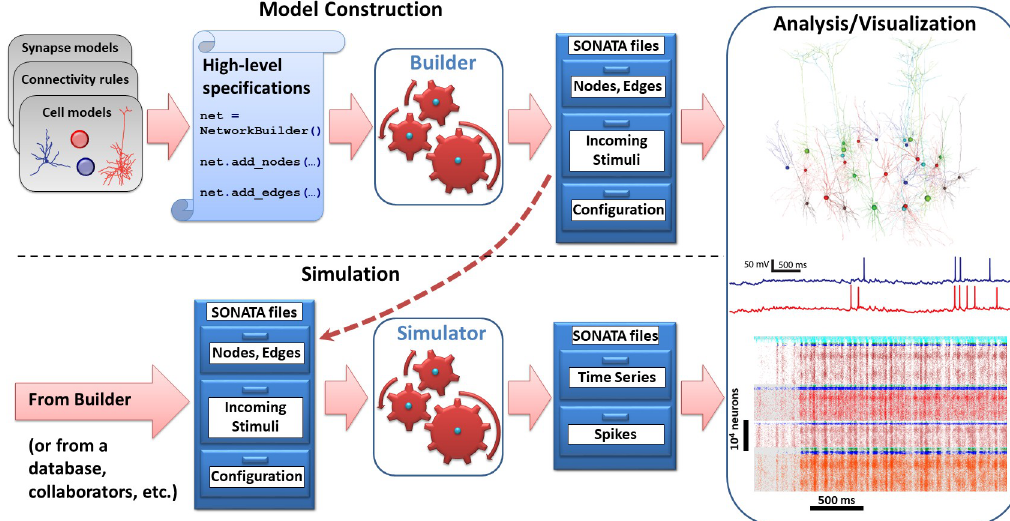
Fig 2. Basic workflow that is conserved across modules of BMTK. Input SONATA files (represented symbolically as chests of drawers) determine the composition and properties of the nodes/network, as well as incoming stimuli (spikes, firing rates, movies) and simulation configuration. Top: the model construction stage. The BMTK Builder combines elements such as cell or synapse models, connectivity rules, and others, via high-level specifications, instantiates the network model, and saves the instantiation as a set of SONATA files. Bottom: simulation stage. The BMTK simulator modules take in the SONATA files as inputs and perform simulations. The input SONATA files may be generated by the BMTK Builder (dashed arrow), any other Builder software supporting SONATA, or from public repositories, collaborators, etc. The BMTK simulator modules produce output, also in SONATA format, typically containing spikes and/or time series (e.g., membrane voltage in selected cells, as a function of time). Right: the SONATA files produced by the BMTK Builder or simulator modules can be analyzed in terms of the model structure or simulated activity (using any analysis software supporting SONATA, or the software that can read HDF5, CSV, and other components of SONATA